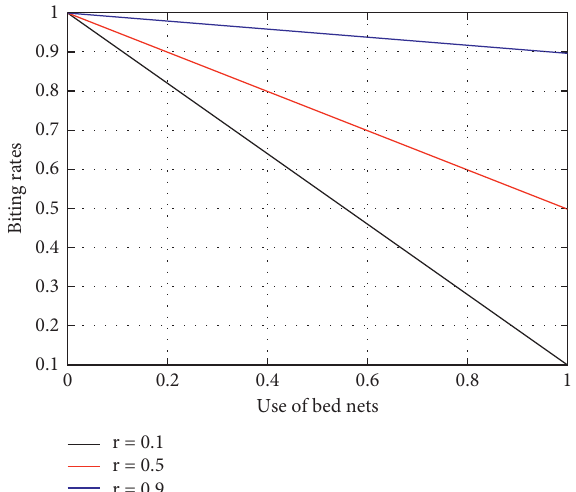
Figure 9: Sensitivity diagram of parameters k and r with the critical � 1. The red colored region defines endemic condition of line R 0 dengue, and the blue colored area defines dengue-free condition.